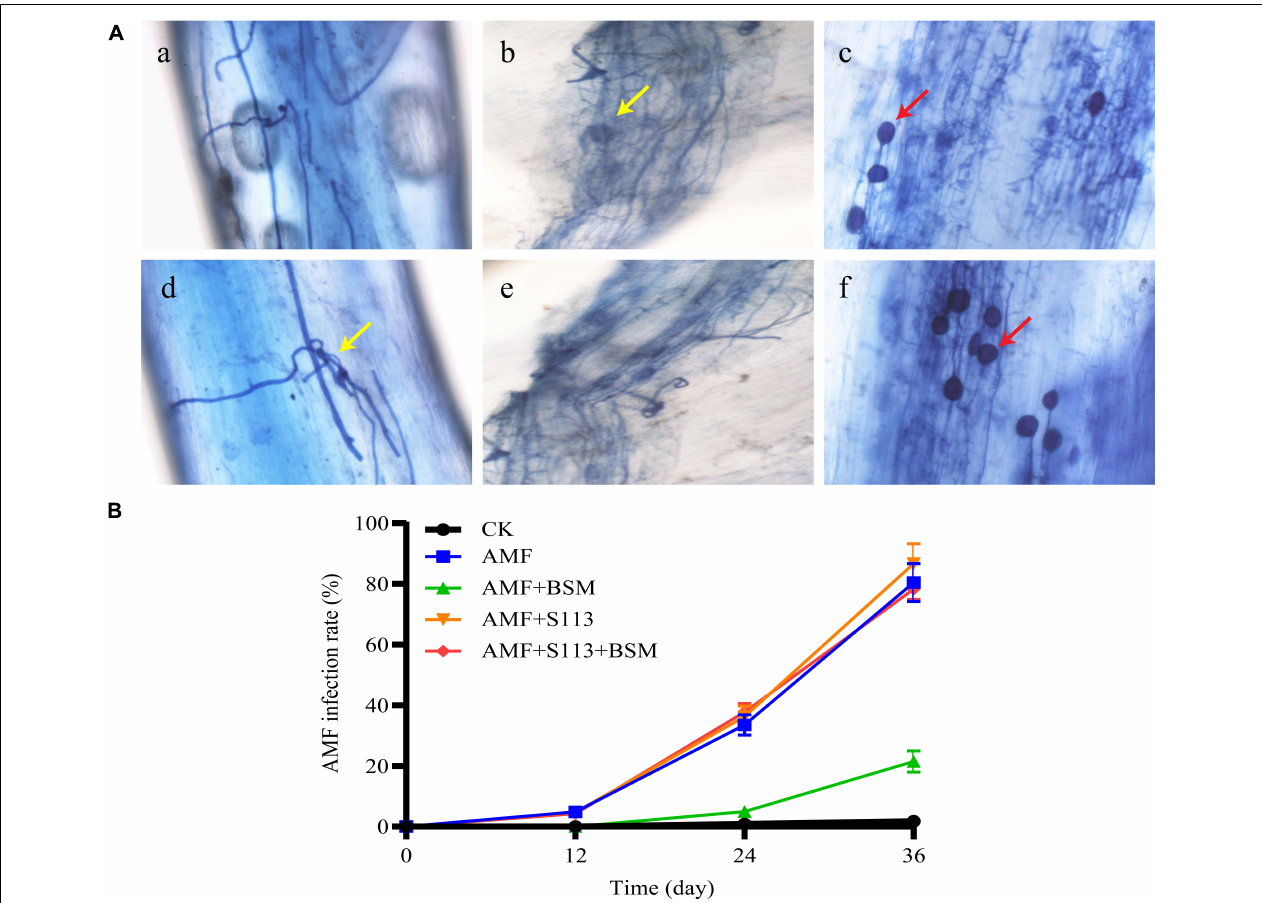
FIGURE 1 | Infection of the Arbuscular mycorrhizal fungi (AMF) to the maize root system. (A) Rhizophagus intraradices colonization in maize roots, as observed under an optical microscope (200 × ). (a) (d) Root segment with low infection rate; (b) (e) Root segment with moderate infection rate; (c) (f) Root segment with high infection rate. The red arrows indicate spores; the yellow arrows indicate hyphae or mycelium. (B) The infection rate of AMF to maize root system under different